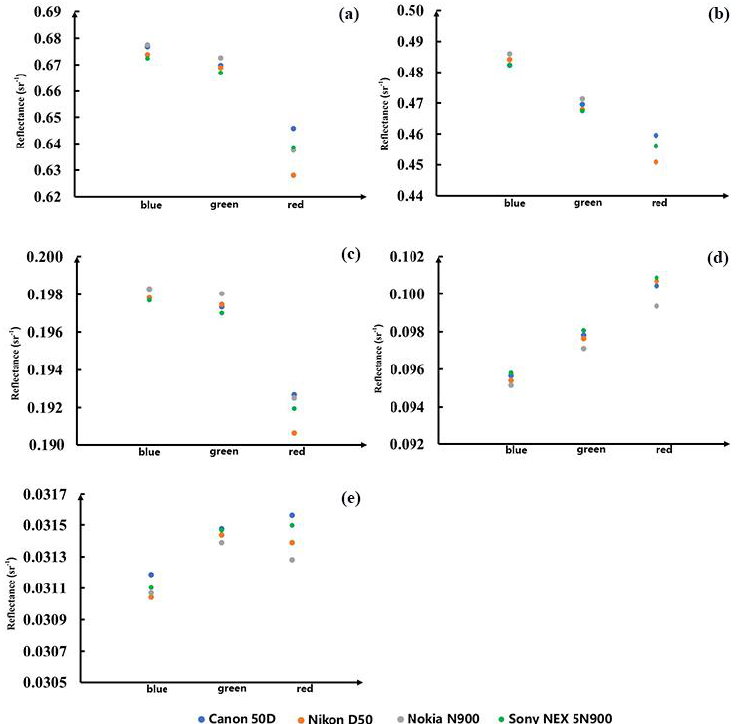
Figure 10. Equivalent reflectance values on the blue, green, red bands for the five-color reference card. ( a ) White card, ( b ) bright gray card, ( c ) medium gray card, ( d ) dark gray card, and ( e ) black card from four cameras.